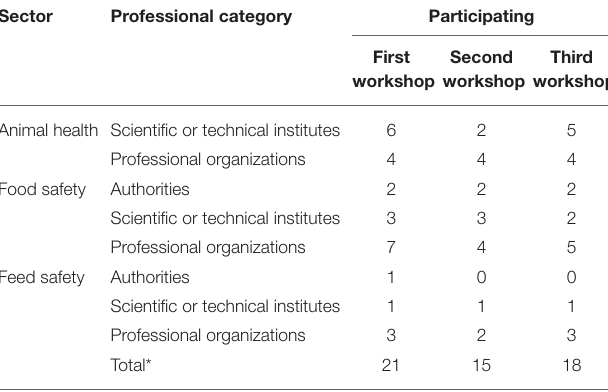
TABLE 3 | Description of the stakeholders invited and participating in the participatory process in France.